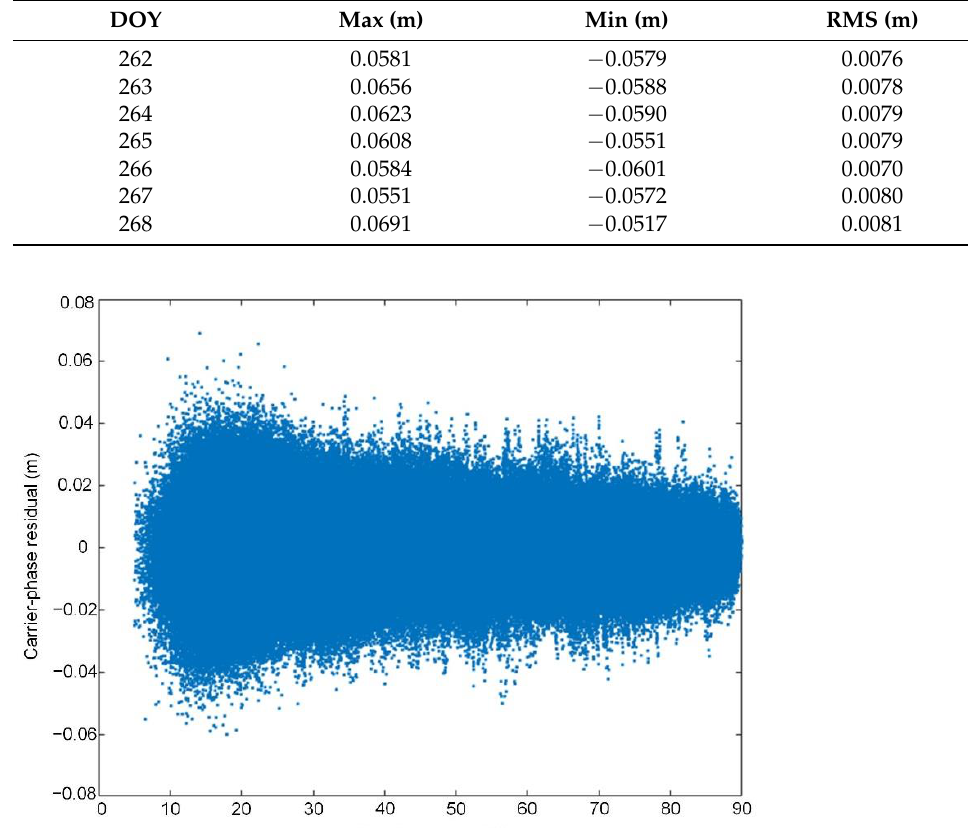
Table 4. Statistics of carrier-phase residuals.